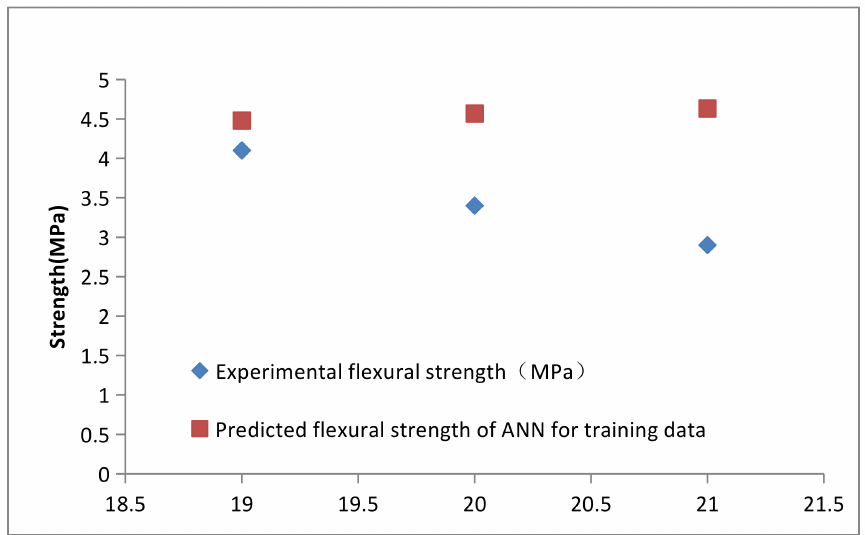
Figure 10. Tested and predicted flexural strength of ANN for testing